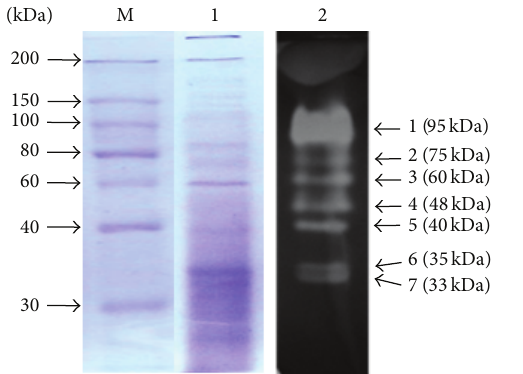
Figure 3: Zymogram analysis shows presence of seven distinct xylanases in crude enzyme preparation of strain X1 grown on wheat bran. Lane 1: Coomassie brilliant blue stained gel; Lane 2: Congo red followed by acetic acid stained gel; and Lane M: protein molecular weight marker.